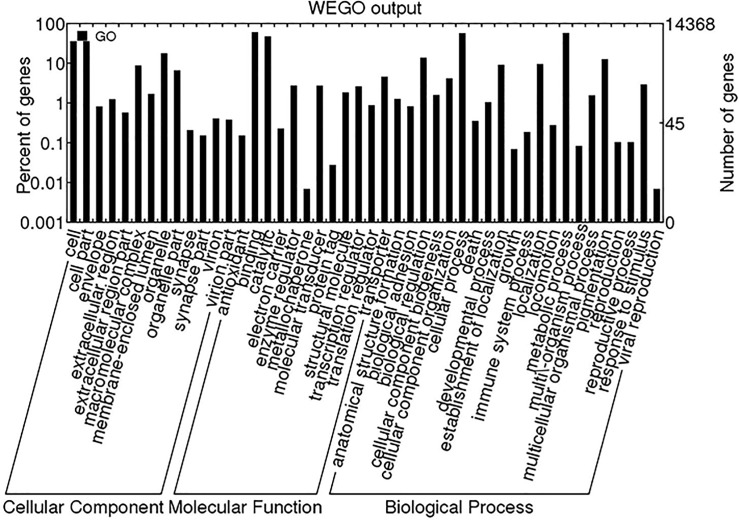
Gene ontology (GO) term distribution.A total of 17,196 unigenes were classified by WEGO software to perform the GO functional classification.